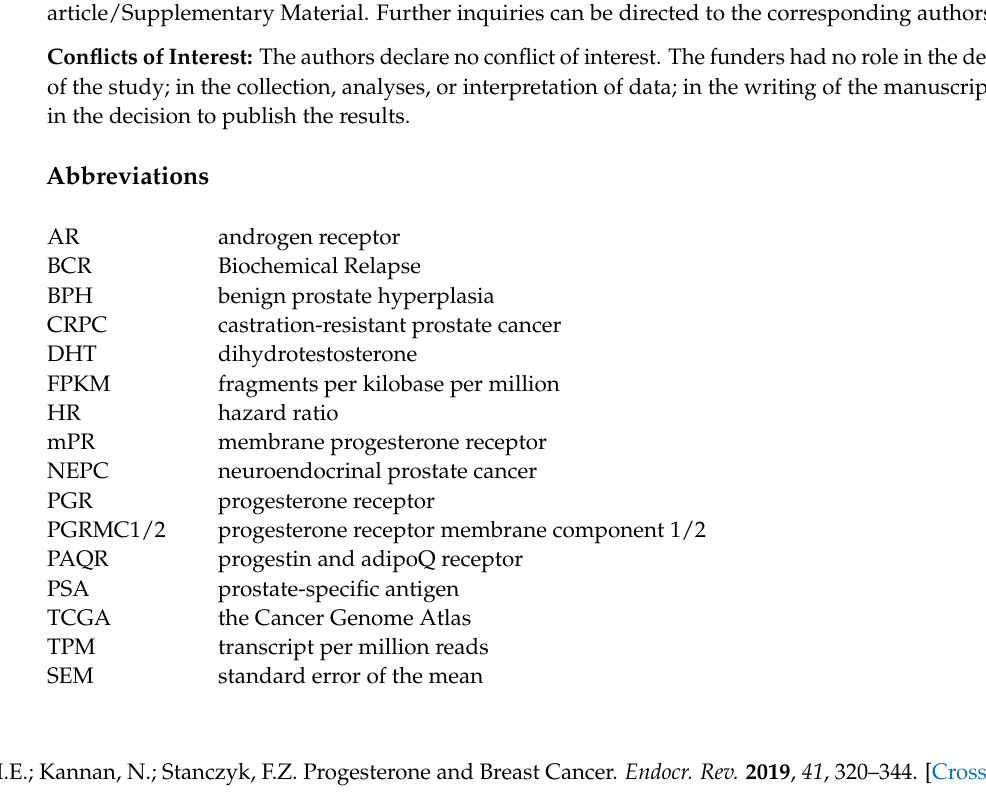
Supplemental Table S3. PGR expression in prostate cancers. Supplemental Table S4. PGRMC1 expression in prostate